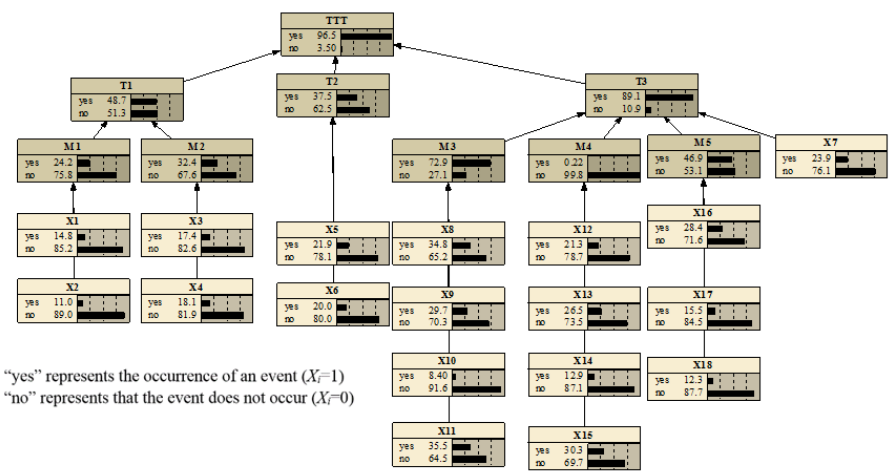
Figure 9. The Bayesian network of bottlenecks of bike-sharing travel based on a fault tree (for example, the probability of the occurrence of event X7 is 23.9% and the probability of non-occurrence is 76.1%).